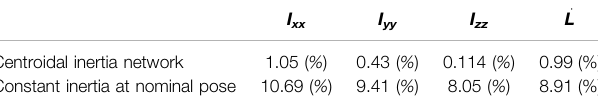
TABLE 2| Average root-mean-squared percent errors of thecentroidal inertia ( I xx , I yy , I zz ) and angular momentum rate ( L ̇ ) predictions when using our trained our centroidal inertia network and a constant inertia computed at a nominal